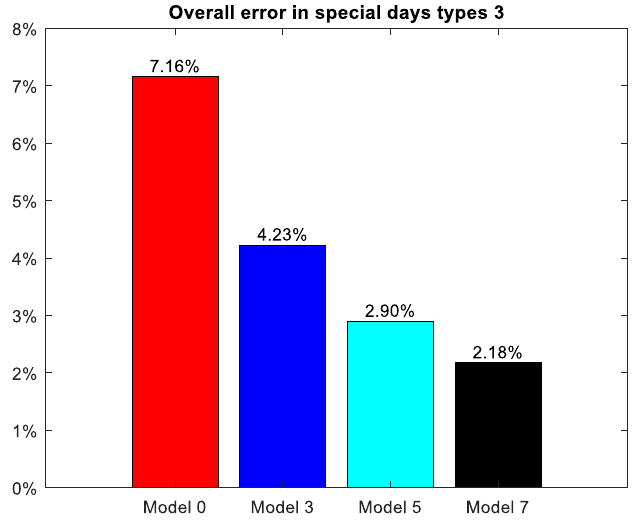
Figure 8. MAPE for models 0, 3, 5 and 7 for all type 3 days.